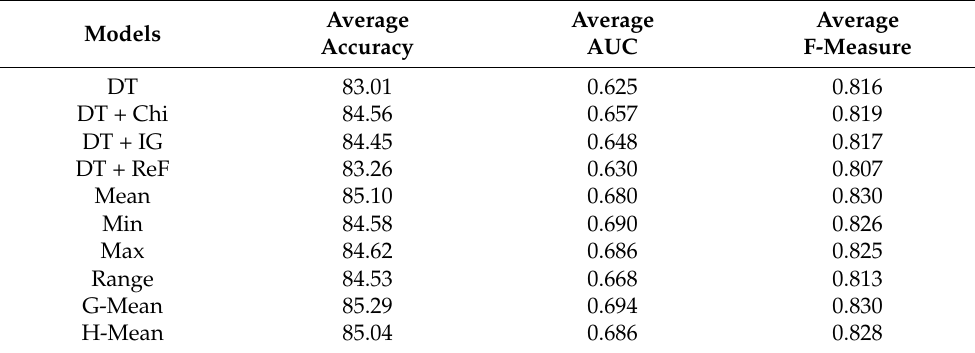
Table 5. Comparison of DT models with proposed FS methods, IG, CS, REF and No FS method.